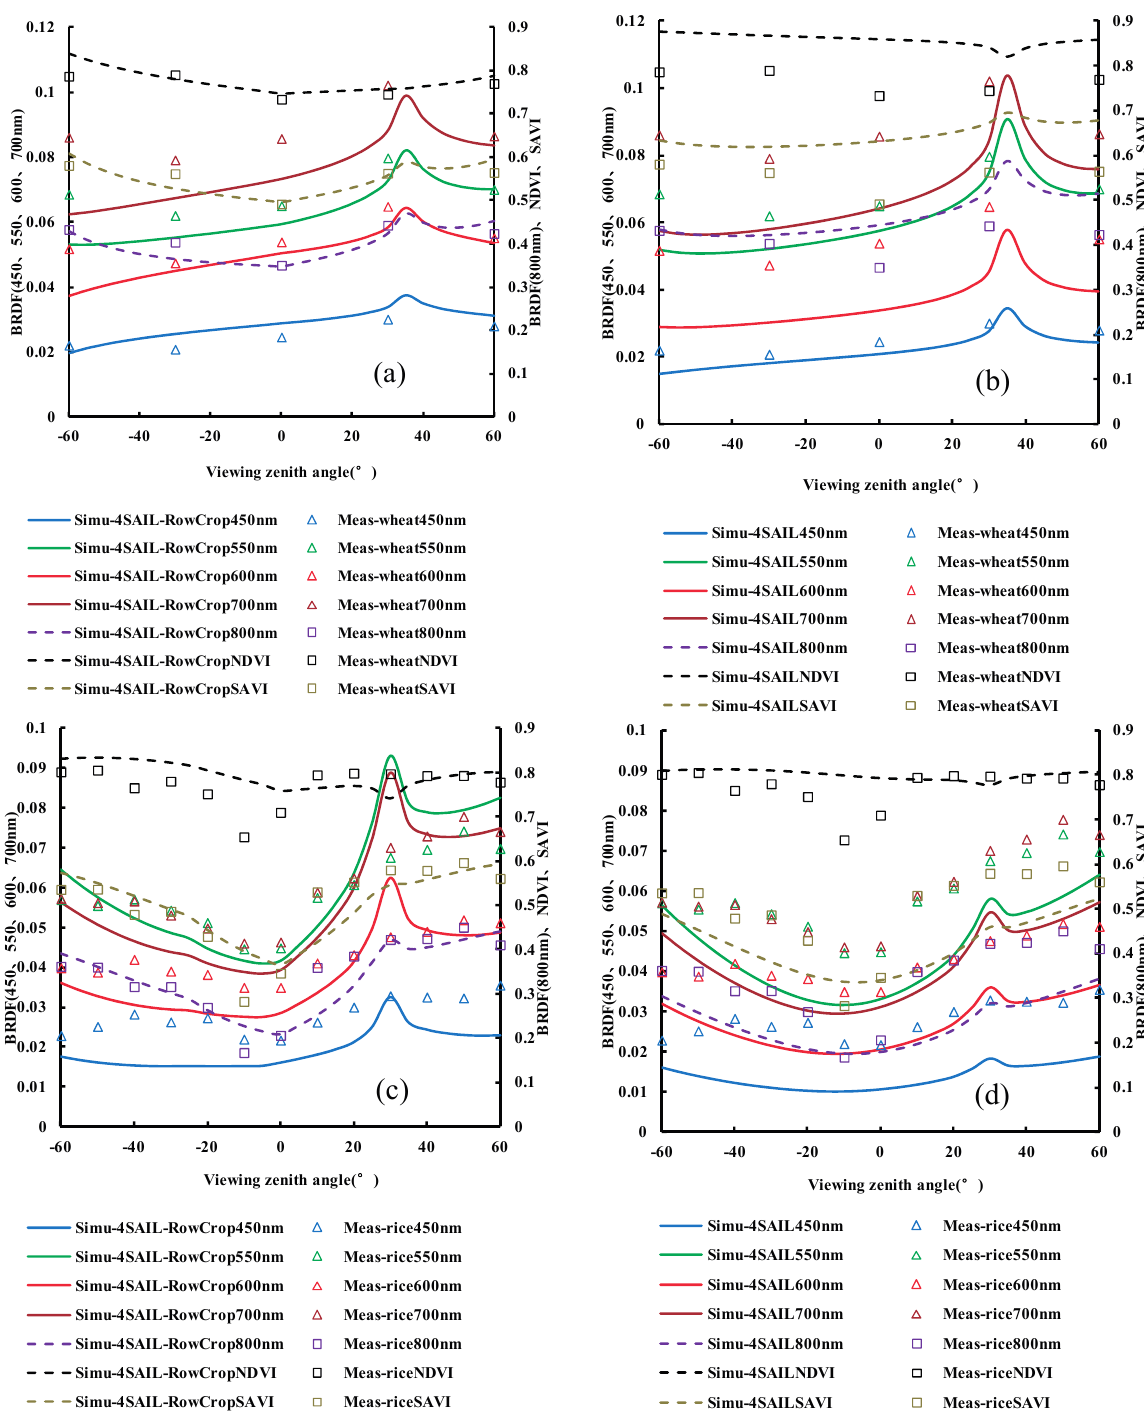
Figure 6. Measured versus simulated wheat bidirectional reflectance factor (BRF) and VI values of the 4SAIL-RowCrop model ( a ) and 4SAIL model ( b ) in the principal plane; measured versus simulated rice BRF and VI values of the 4SAIL-RowCrop model ( c ) and 4SAIL model ( d ) in the principal plane. The viewing zenith angles are from − 60° (forward direction) to +60° (backward direction) at 30° or 10° intervals in the principal plane (PP). The viewing azimuth angle is aligned with the solar azimuth